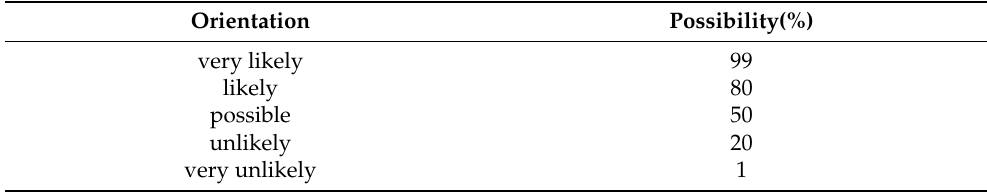
Table 3. The correspondence between the orientation of experts and the possibility value.